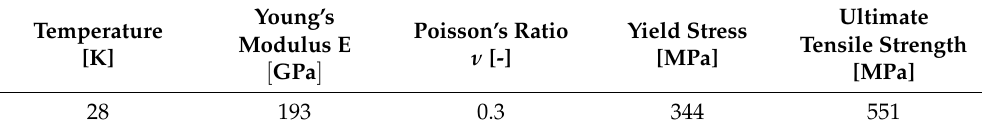
Table 7. Mechanical properties of the electrodeposited nickel.